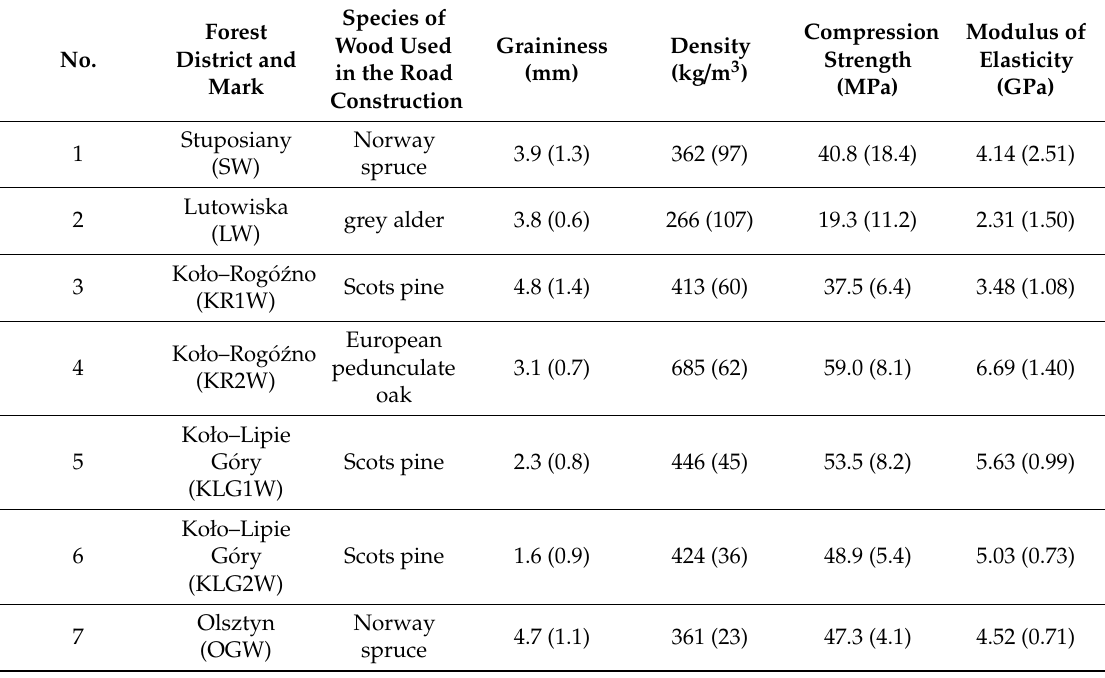
Table 3. Results of selected physical and mechanical properties of wood from forest roads and references—mean value (standard